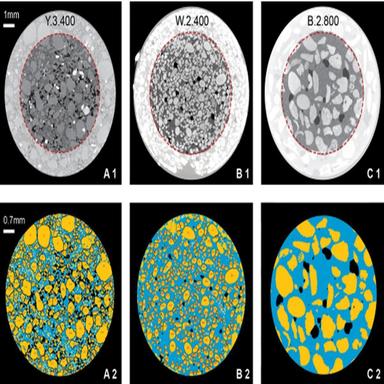
X-ray tomography scan (top) and analysis (bottom) of one slice of each type of sand; the yellow (left), the white (middle) and the brown (right). . (For interpretation of the references to color in this figure legend, the reader is referred to the web version of this article.)